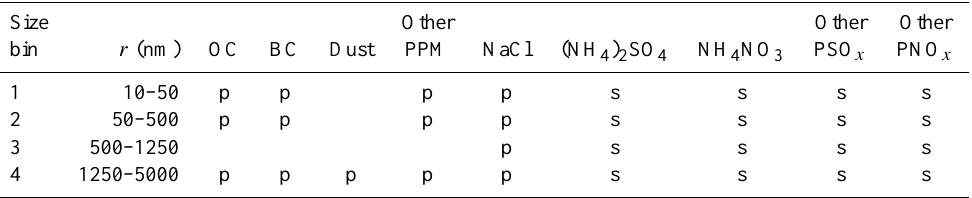
Table 1. Size bins (characterized by the radius r ) and chemical species in the MATCH mass transport model (Andersson et al., 2007). The labels “p” and “s” refer to primary emitted particles and secondary particles generated from gas precursors. Size